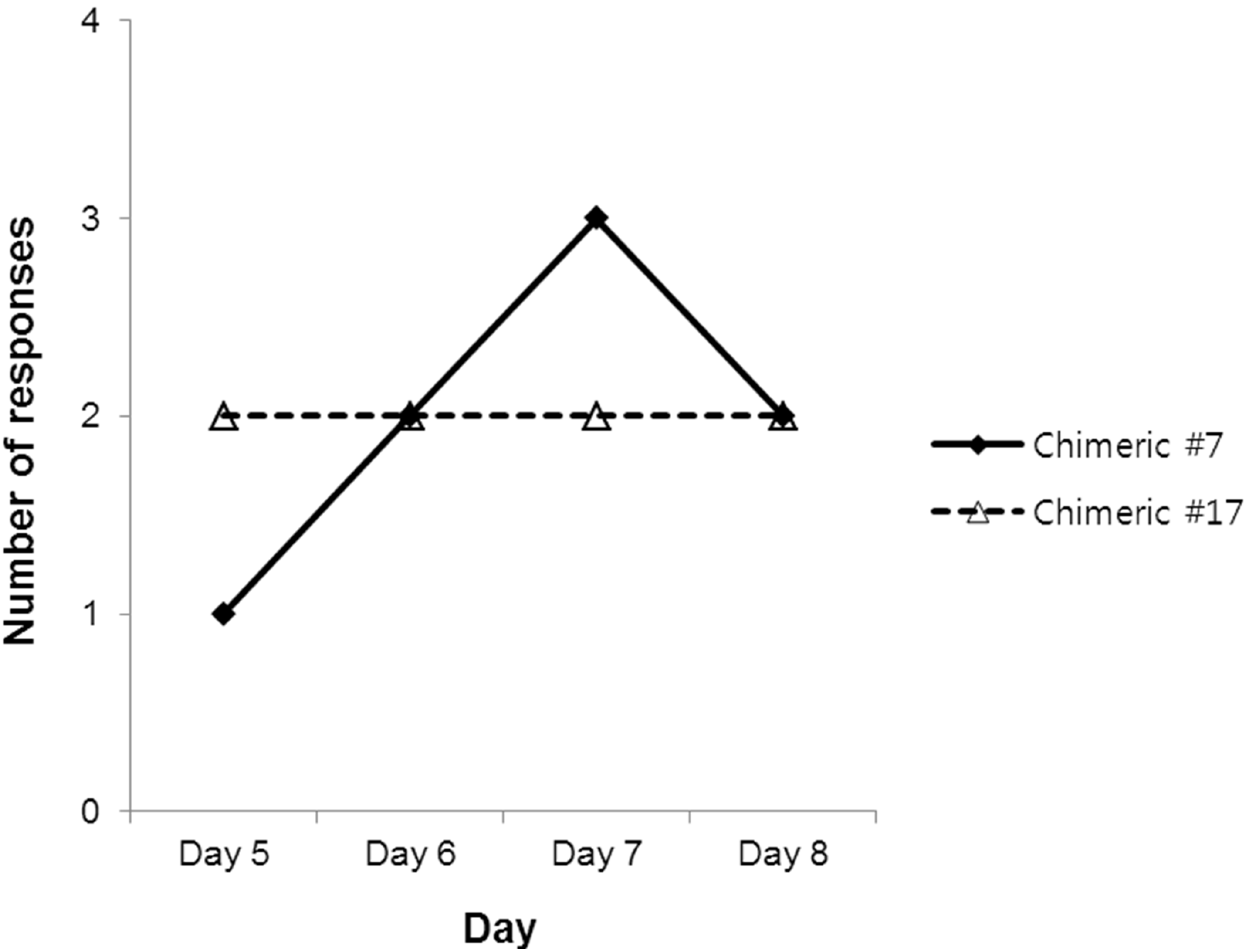
Fig 5. The number of T cell proliferative responses detected at four time points. T cell proliferationwas assessedby [ 3 H]-thymine uptake on days 5, 6, 7, and 8 after incubation with the antibodies,and the number of positive responders was plotted.